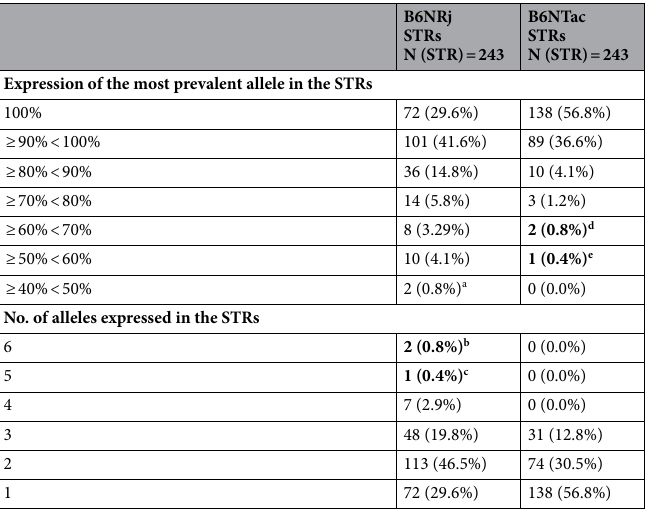
B6NRj STRs N (STR) = 243 N (STR) = 243